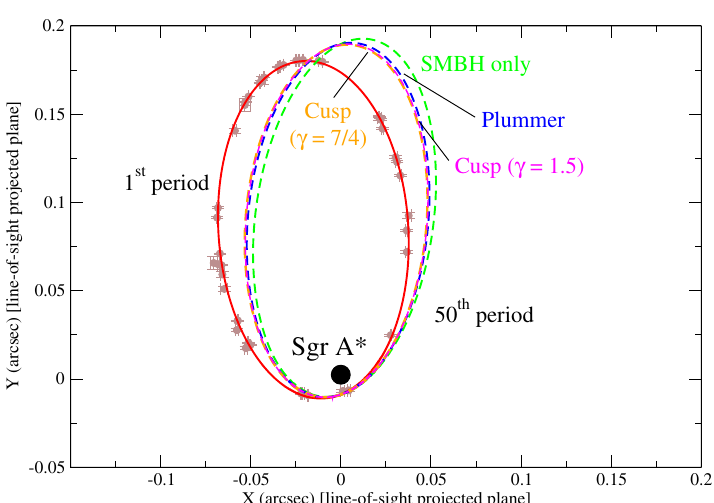
Figure 1. The red ellipse represents the best-fit orbit of the S2 star based on the observational data in brown dots with error bars 32 on the apparent projected orbital plane (XY-plane). The green, orange, magenta, and blue dashed lines respectively represent the predicted orbits of the S2 star after the 50th period for the ‘SMBH model’, ‘SMBH+DM model’ with the Bahcall-Wolf cusp distribution ( γ = 7 / 4 ), ‘SMBM+DM model’ with the cusp distribution γ = 1.5 , and the ‘SMBH+DM model’ with the Plummer distribution (transformed to the apparent projected orbital plane). The position of the SMBH (Sgr A*) is at ( X , Y ) = ( − 0.000083 ′′ , 0.0024893 ′′ ) 21